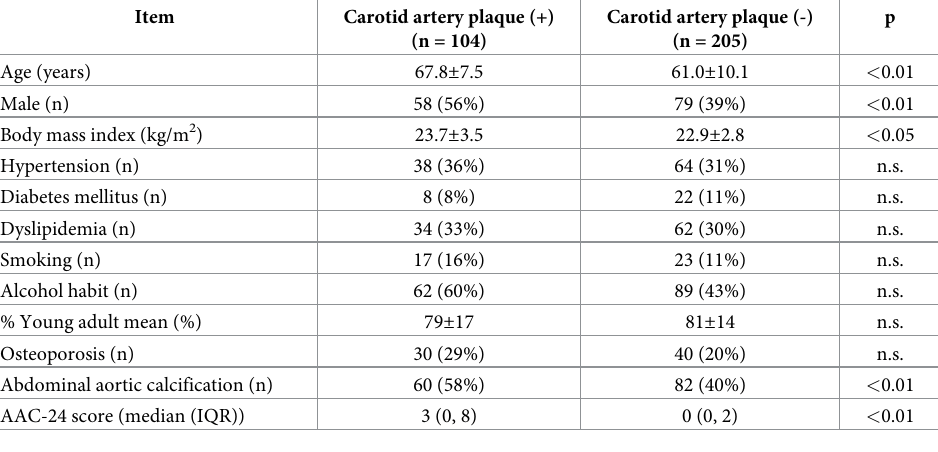
Table 4. Difference in variables between subjects with and without carotid artery